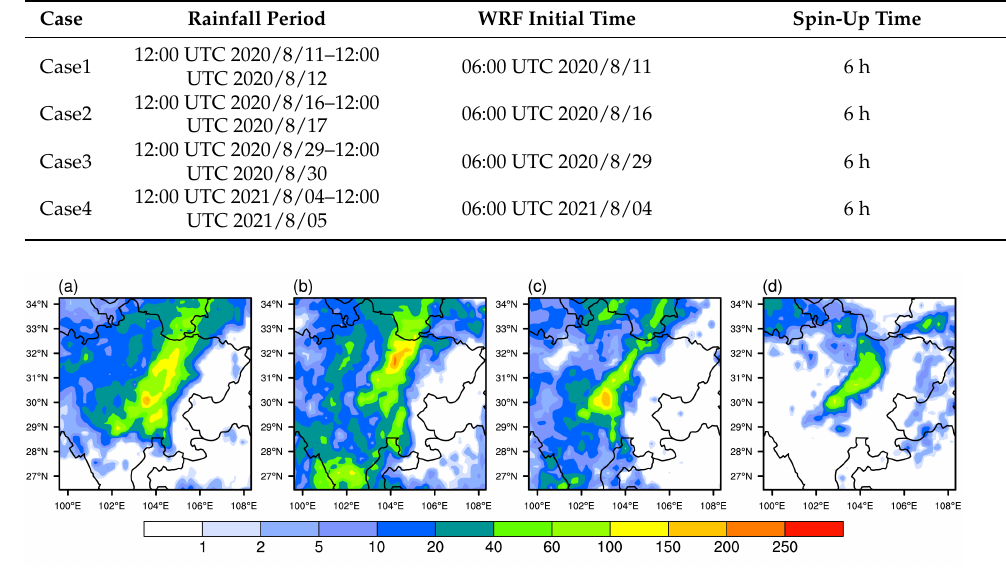
Figure 3. ( a – d ) show the observation of 24-h accumulated precipitation (mm) for Case1 to Case4 respectively.